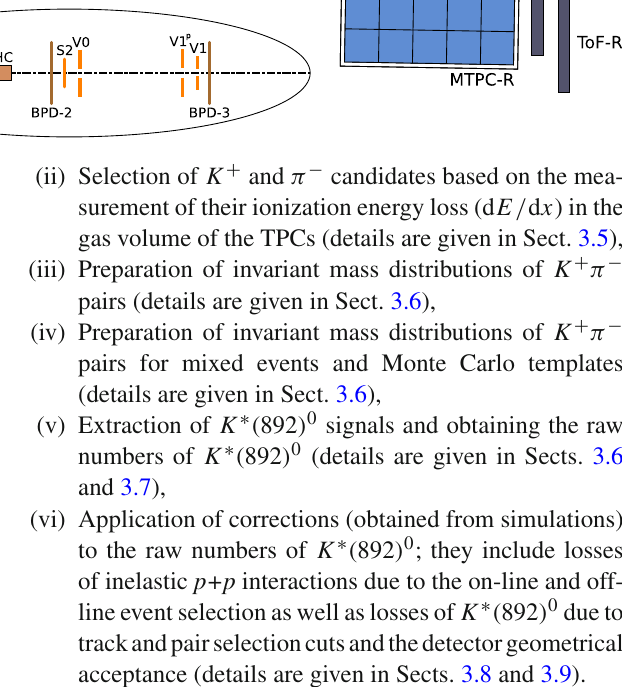
Fig. 1 The schematic layout of the NA61/SHINE spectrometer (horizontal cut, not to scale) used for p+p data taking. The beam and trigger detector configuration is shown in the inset (see Refs. [23,24] for detailed description). The chosen coordinate system is drawn on the lower left: its origin lies in the middle of the VTPC-2, on the beam